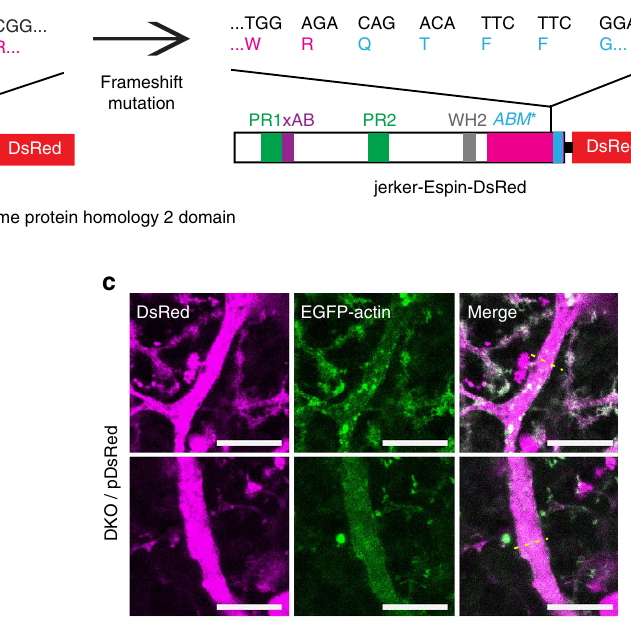
dendritogenesis and dendritic spine morphogenesis in postnatal PCs through regulating Espin expression. Conditional knockout of Lhx1/5 in postnatal PCs leads to downregulation of Espin, resulting in F-actin mislocalization in the proximal dendrites of PCs. This thereby impairs the elongation and branching of PC dendrites in Lhx1/5 DKO mutants. Since spine maturation is also disrupted due to reduced Espin expression, synaptogenesis and